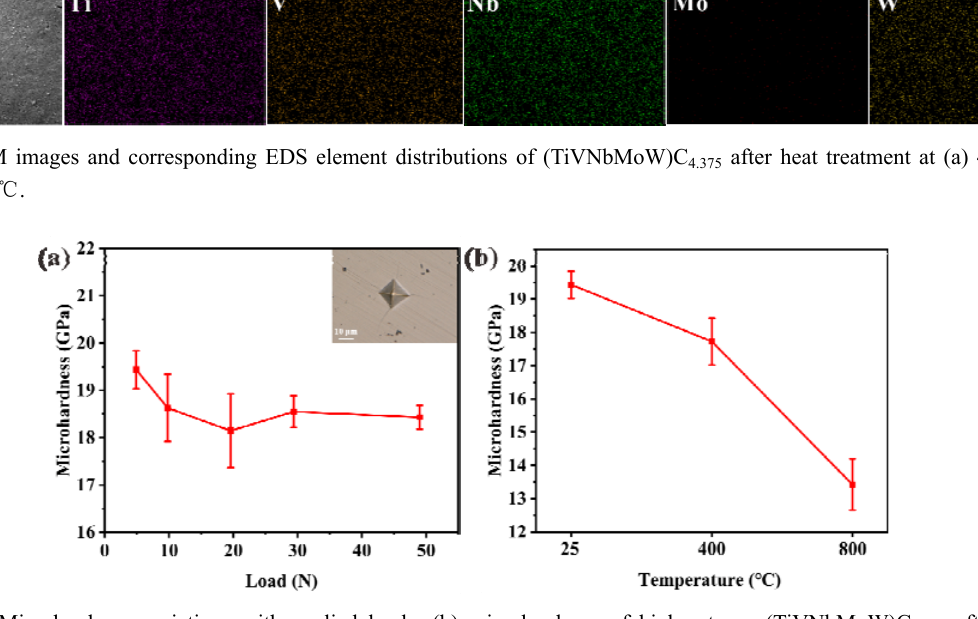
Fig. 8 (a) Microhardness variations with applied loads; (b) microhardness of high-entropy (TiVNbMoW)C 4.375 after heat treatment for 1 h at RT, 400 ℃ , and 800 ℃